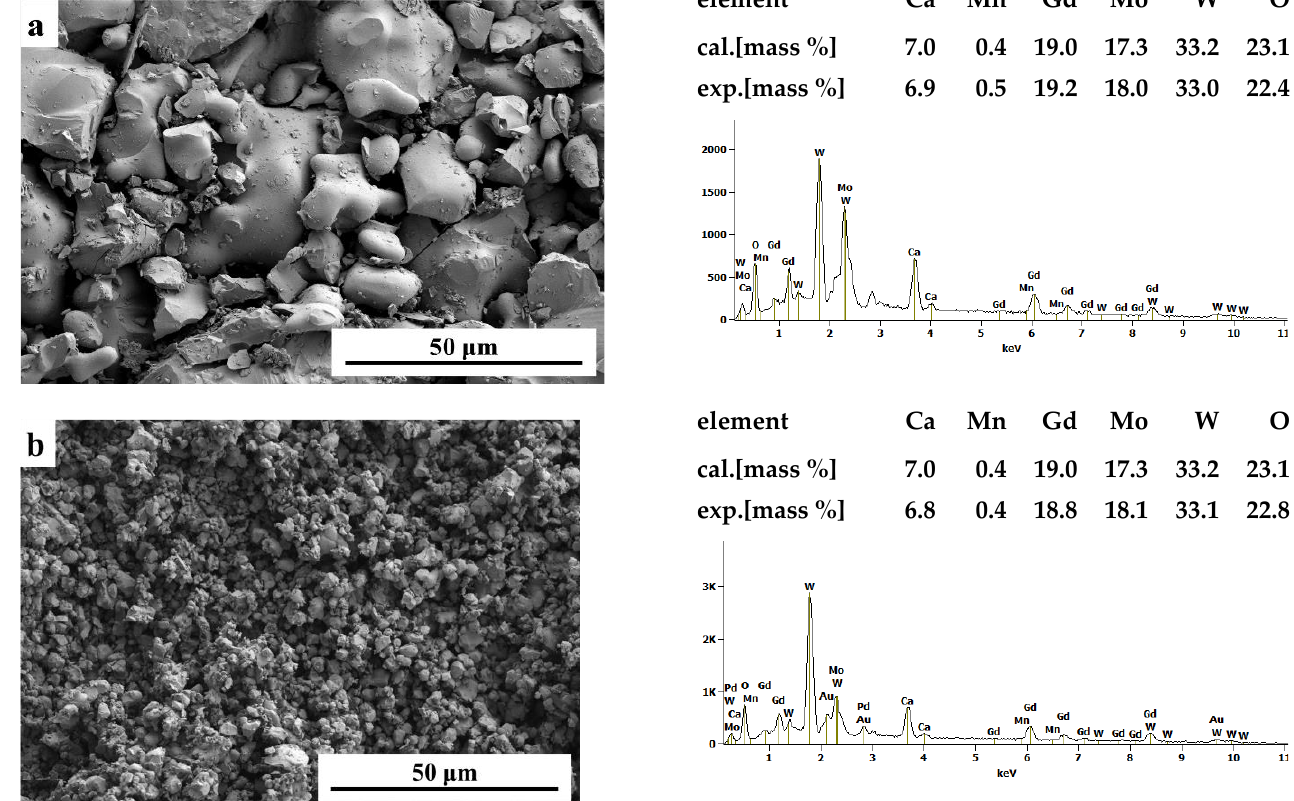
Figure 5. SEM (secondary electrons) images and EDS elemental analysis of CaMnGdMoWO sam- ples when x = 0.1667 and y = 0.0200 obtained by high-temperature sintering ( a ) and combustion method ( b